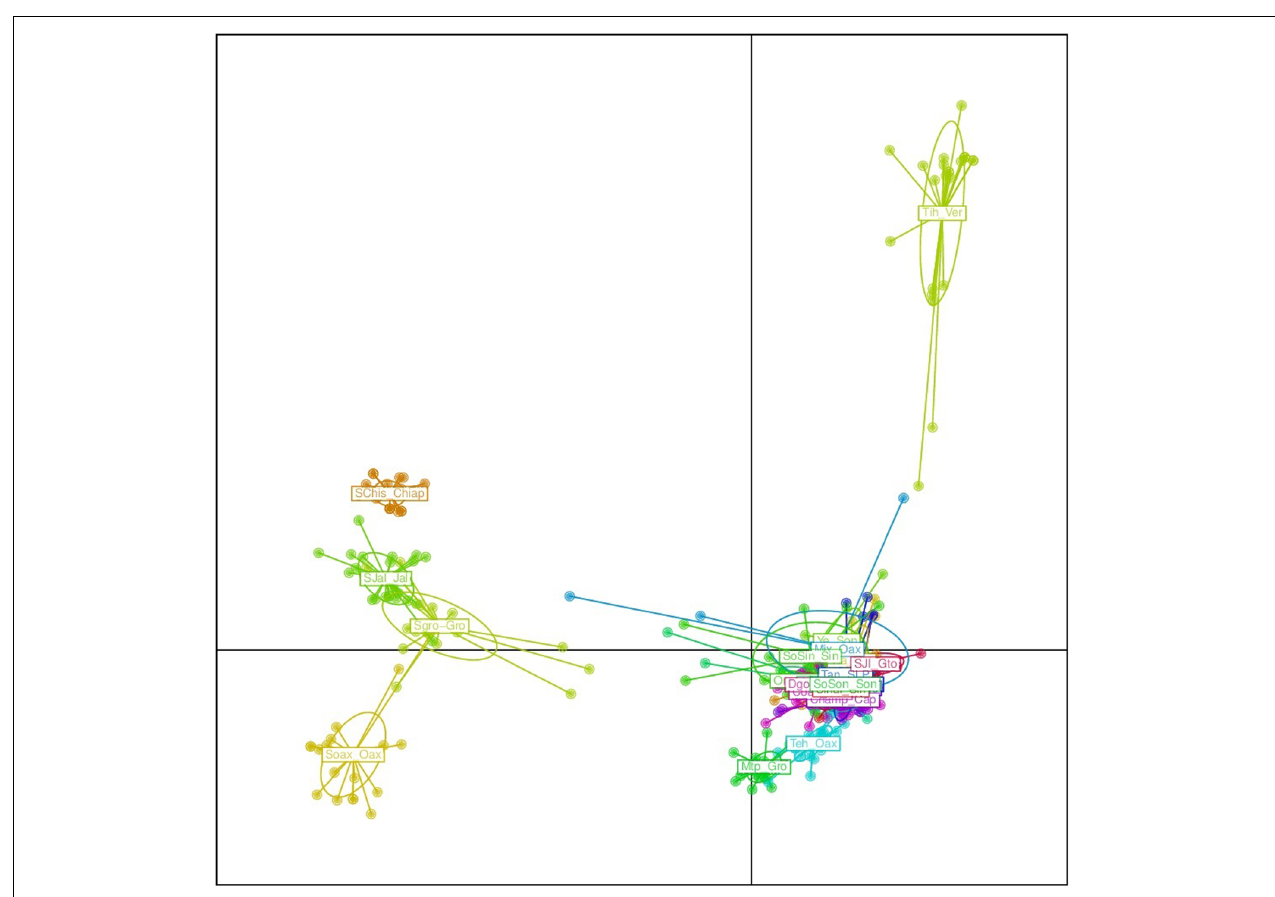
FIGURE 5 | Discriminant analysis of principal components (DAPC) for 19 argyrosperma and 6 sororia populations. Names starting with S or So correspond to sororia populations. Four sororia populations are well differentiated from the argyrosperma